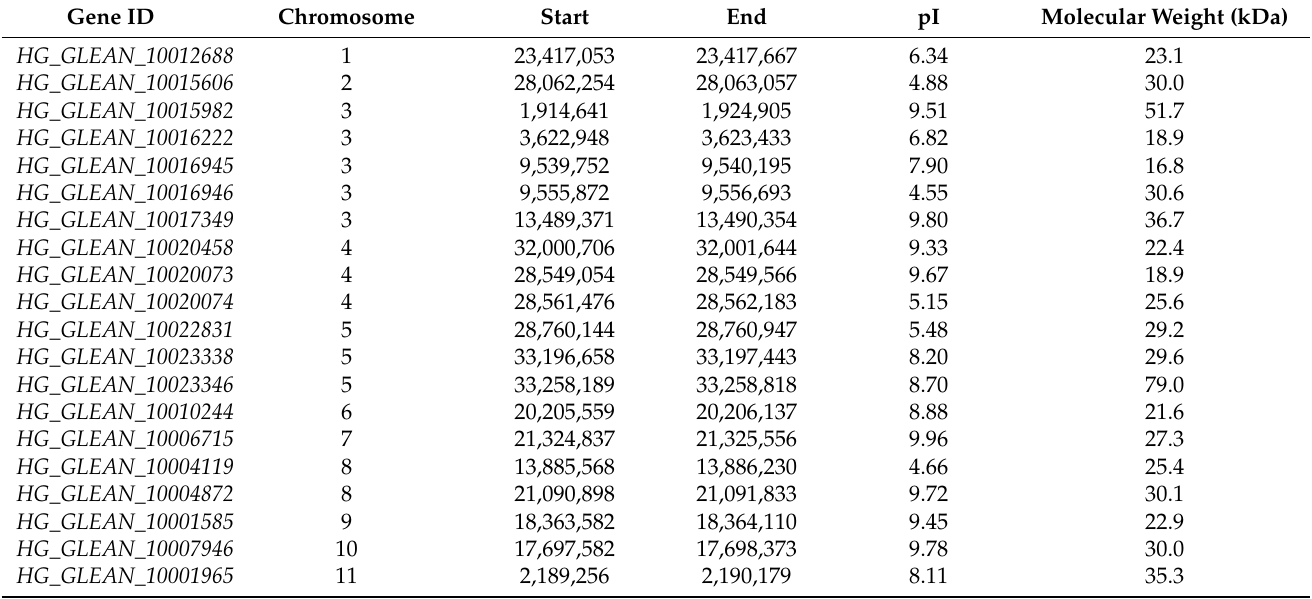
Table 1. Twenty OVATE family genes in bottle